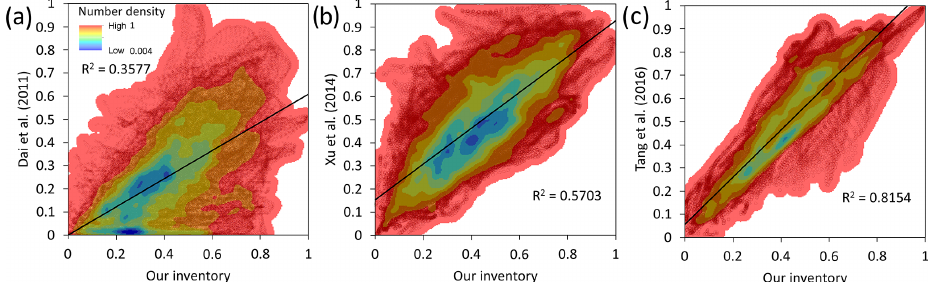
Figure 9. Pixel-based spatial correlation of landslide densities. The comparisons between our inventory map and those obtained by Dai et al. (2011) (a) , Xu et al. (2014) (b) and Tang et al. (2016) (c) are shown.